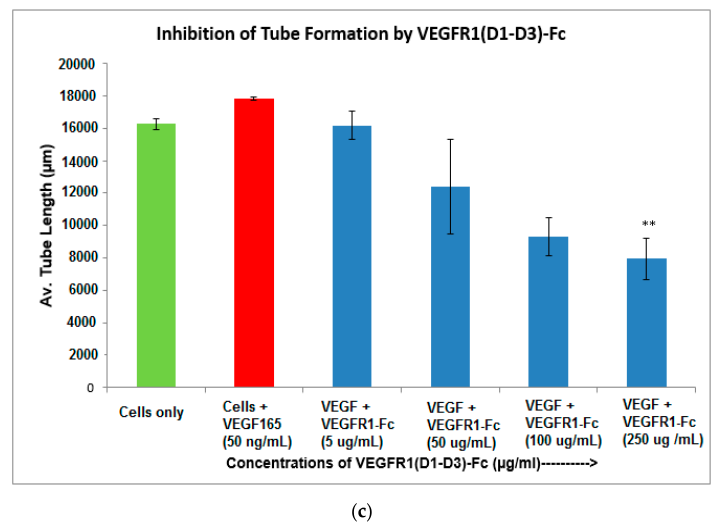
Figure 7. ( a ) Endothelial cell proliferation assay of VEGFR1(D1–D3)-Fc; **, p ≤ 0.01, ***, p ≤ 0.001; ****, p ≤ 0.0001; ( b ) images of endothelial tube formation assay for VEGFR1(D1–D3-Fc. Images were